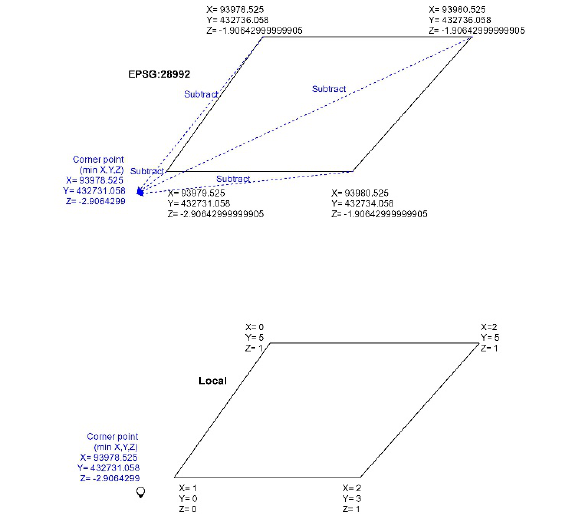
Figure 4. Creating a reference point based on minimum values Secondly, the values of all points are converted to local referencing in relation to the reference point. The local referencing is calculated by subtracting the values of all points from the reference point value, which is shown in Figure 5.